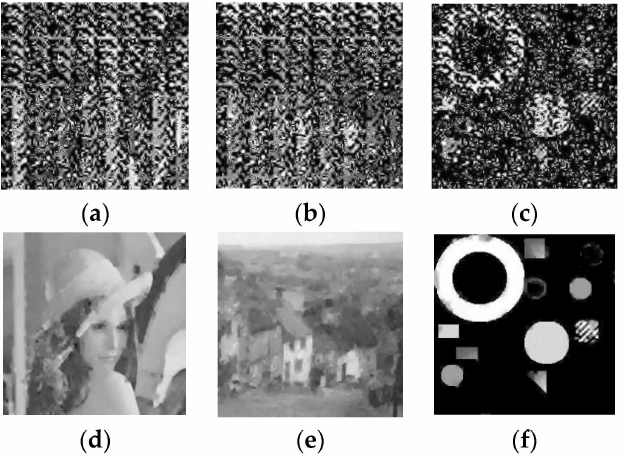
Figure 6. 5% wavelet coefficients are corrupted by salt-pepper noise and 50% coefficients are lost. ( a – c ) received images. ( d – f ) images reconstructed by